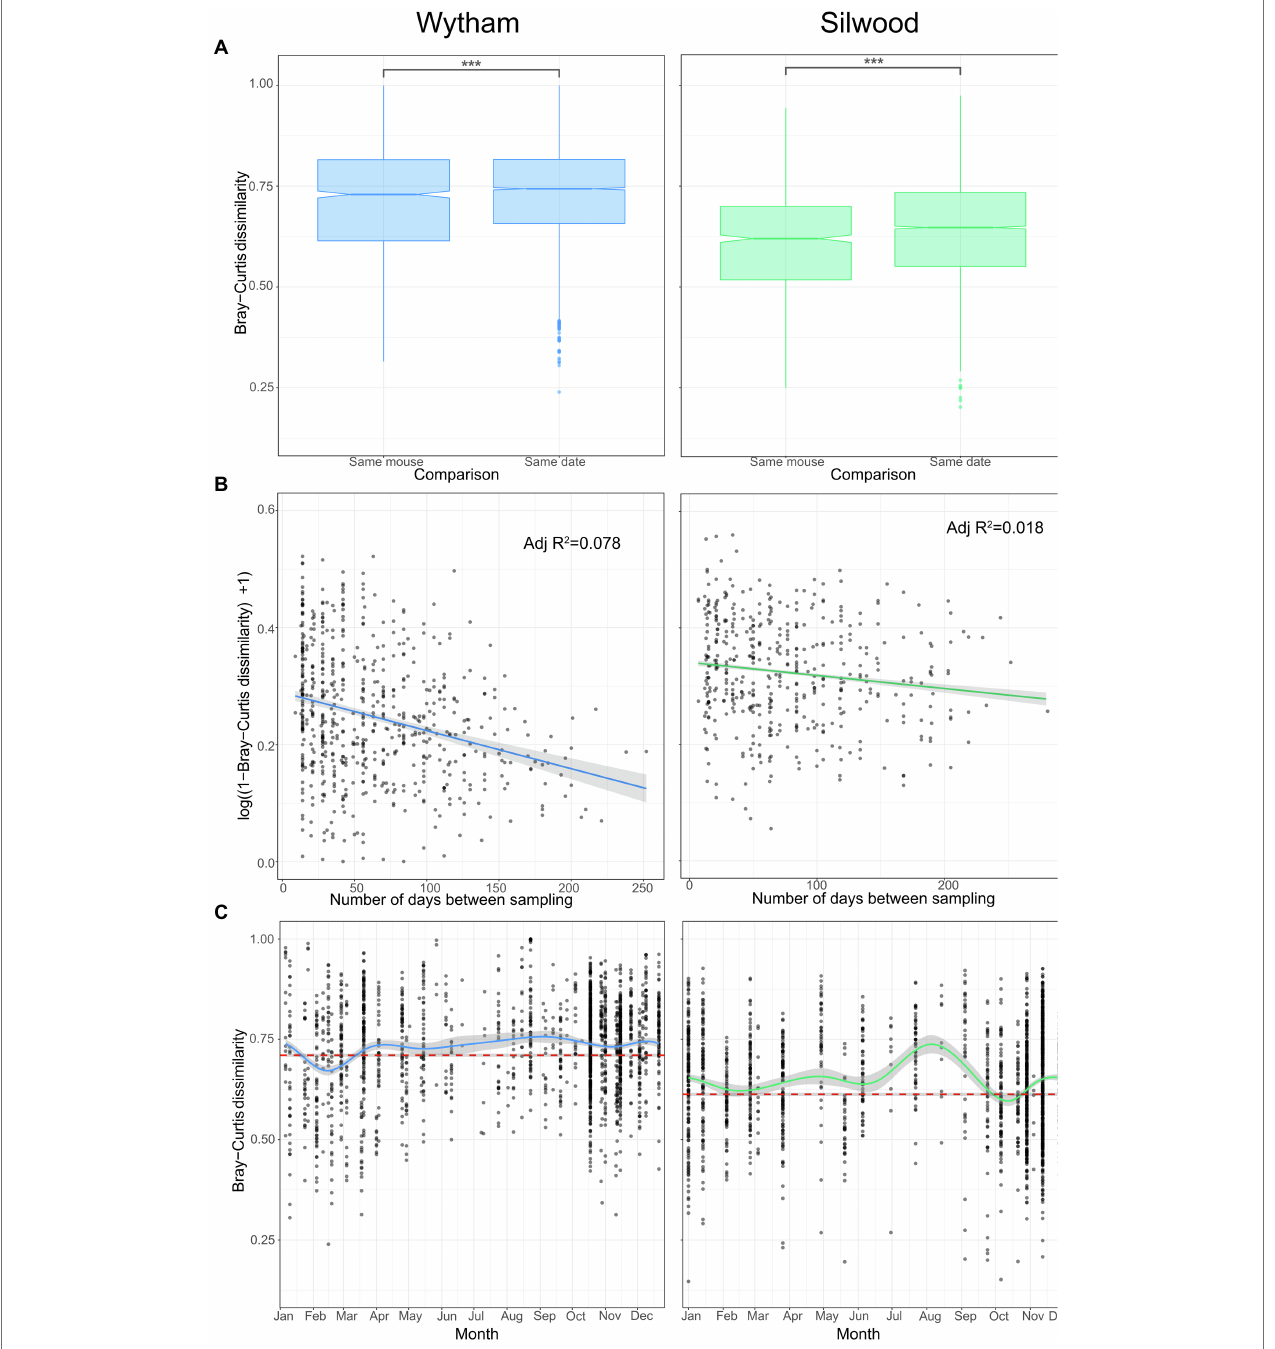
FIGURE 4 | Intra- and inter-individual variation in gut community structure varies with time in two wild populations. (A) Pairwise Bray–Curtis dissimilarity between samples from the same host at different times (same mouse) and those taken from different hosts on the same day (same date) were used to compare intra- and inter-individual variation in Wytham (blue) and Silwood (green) wild populations. Significant differences between groups were tested with permutational Wilcoxon tests and are denoted by asterisks (***; p < 0.001). (B) Intra-individual variation decays with sampling interval. Community similarity (1-Bray–Curtis dissimilarity) between pairs of samples collected from the same individual host (in mice that were captured three or more times, Wytham; n = 277 samples from 57 hosts and Silwood; n = 197 samples from 39 hosts) are plotted against the sampling interval. Community similarity is log-transformed and the relationship fitted using a log-linear model. (C) Inter-individual variation across the year was visualised by plotting the Bray–Curtis dissimilarity between individuals sampled in the same trapping session, with a loess smoothing line for each population. The mean (±SE) intra-individual Bray–Curtis dissimilarity per population is shown as a dashed reference line in